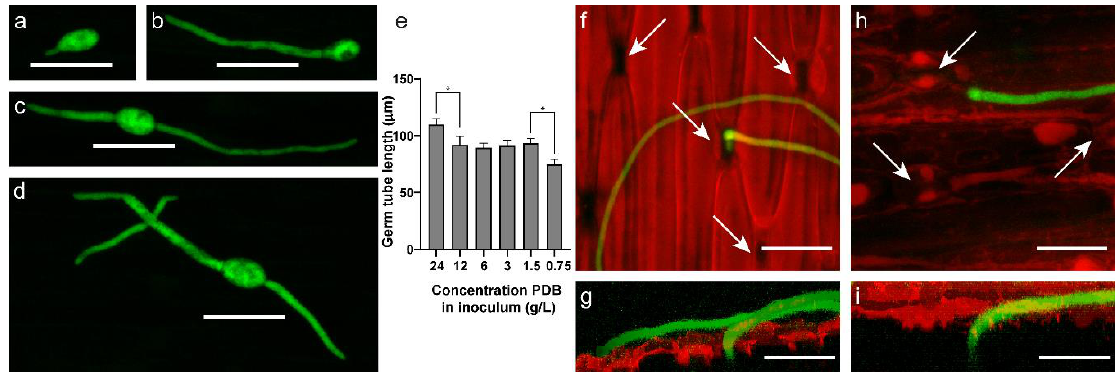
Figure 2. B. squamosa growth on and penetration of the onion leaf surface. Fluorescence microscope images of spores germinating ( a , b ) unipolar and ( c ) bipolar, and ( d ) a branching germ tube. ( e ) The effect of nutrient concentration in the inoculum on germ tube length at 8 h post inoculation (HPI) on the onion leaf surface, (unpaired t -test, * p < 0.05, error bars representing standard error). Confocal laser scanning microscopy images of B. squamosa penetrating the onion leaf surface. ( f ) Top view and ( g ) front view of a 3D projection of stomatal penetration. ( h ) Top view and ( i ) front view of a 3D projection of growth into anticlinal walls of epidermal cells. All scale bars represent 50 µm, arrows indicate stomata, B. squamosa -GFP (green fluorescent protein) in green and propidium iodide-stained onion cell walls in red.